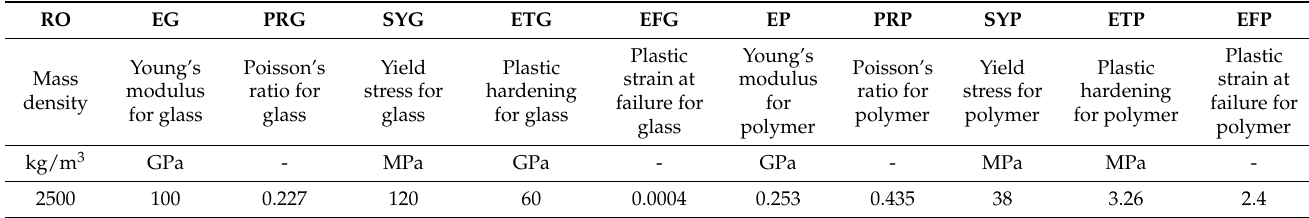
Table 2. New parameters of VSG glass reinforced with PVB interlayers.